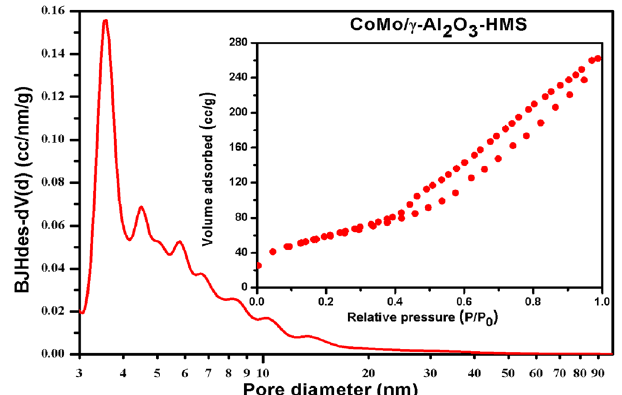
Figure 2. Pore size distribution and adsorption–desorption isotherm of the CoMo/γ-Al 2 O 3 –HMS catalyst.